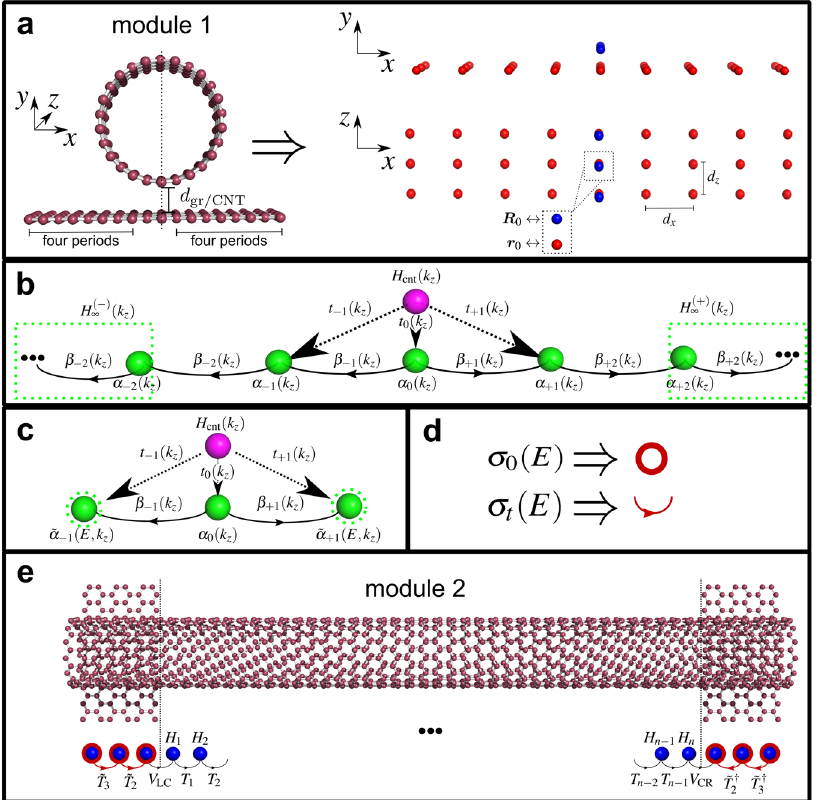
Fig. 7 Schematic overview of the procedure to calculate the graphene self-energy and the following decoration of the carbon nanotube (CNT) contact elements. a Module 1 represents the carbon system of the all-carbon fi eld effect transistor deep within the contact region and is visualized as a 3D block tight-binding system with the red and blue spheres representing the CNT and graphene unit cells, respectively. The reference unit cells for the k z -space transformations are denoted with R 0 (CNT) and r 0 (graphene). b After k z -transformation, one obtains a planar block tight-binding system where the k z - dependent CNT element is depicted in purple, while the graphene on-site cells are green. c Decimation of the semi-in fi nite chain results in a fi nite planar system with an additional energy dependence from which the graphene self-energy in k z − space can be computed. d Inverse Fourier transformation is used to obtain the on-site σ 0 ( E ) and hopping σ t ( E ) elements of the self-energy. e Visualization of module 2 as an effective one-dimensional tight-binding chain. All matrix elements relevant for quantum transport calculations of CNTFETs with arbitrary contact lengths are extracted from the fi nite matrices H (2) and S (2) . In accordance with the usual non-equilibrium Greens function scheme, the left H L , central H C, and right H R subsystems are speci fi ed. On- and off- site hopping matrices in the contact regions are decorated with the self-energies, which have been obtained from module